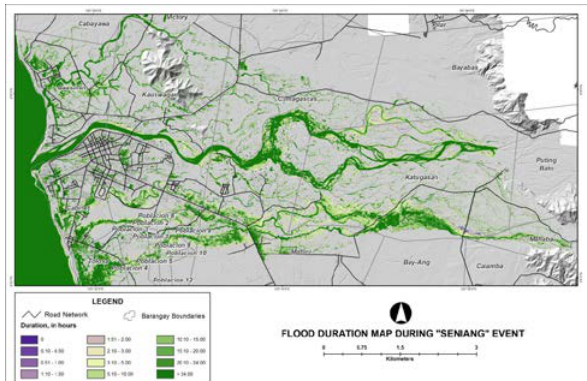
Figure 10. Map of flood duration for the Seniang event.